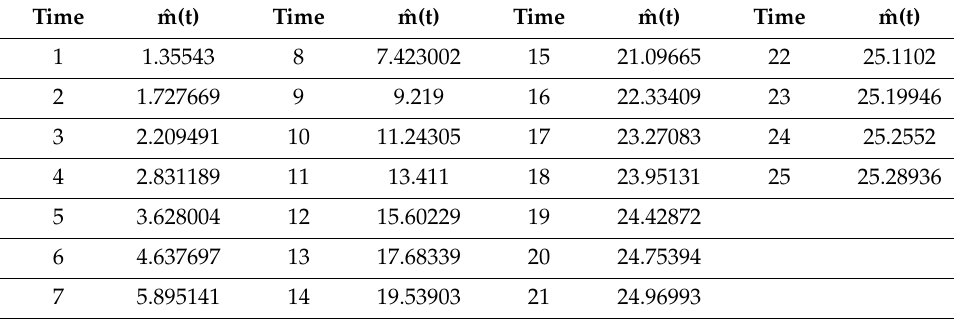
Table 6. Predicted values by proposed model for dataset 1.